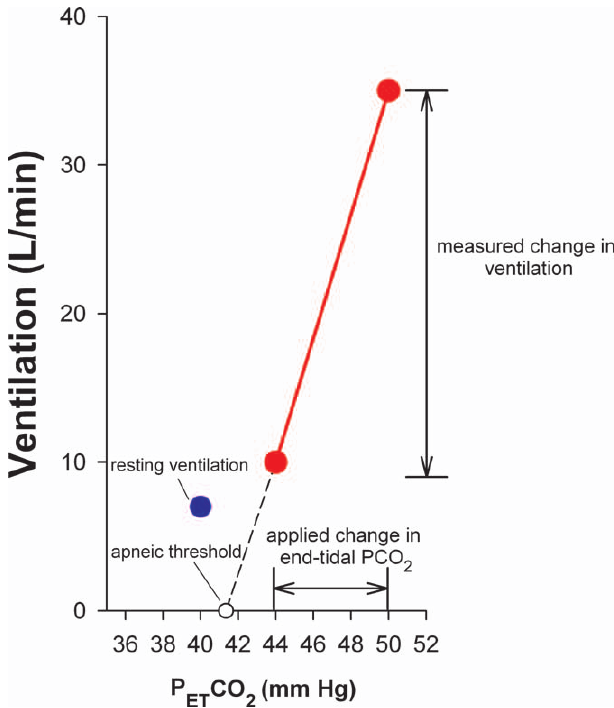
Figure 2. An Example of the Steady-State Ventilatory Response to an Increase in P ET CO 2 from 44 to 50 mm Hg The response is linear (continuous red line) over the given trajectory; the extrapolated P ET CO 2 (red circles) at which ventilation is zero is given (in this example it is 41.3 mm Hg, open symbol). Resting ventilation and resting P ET CO 2 are also shown (blue circle).